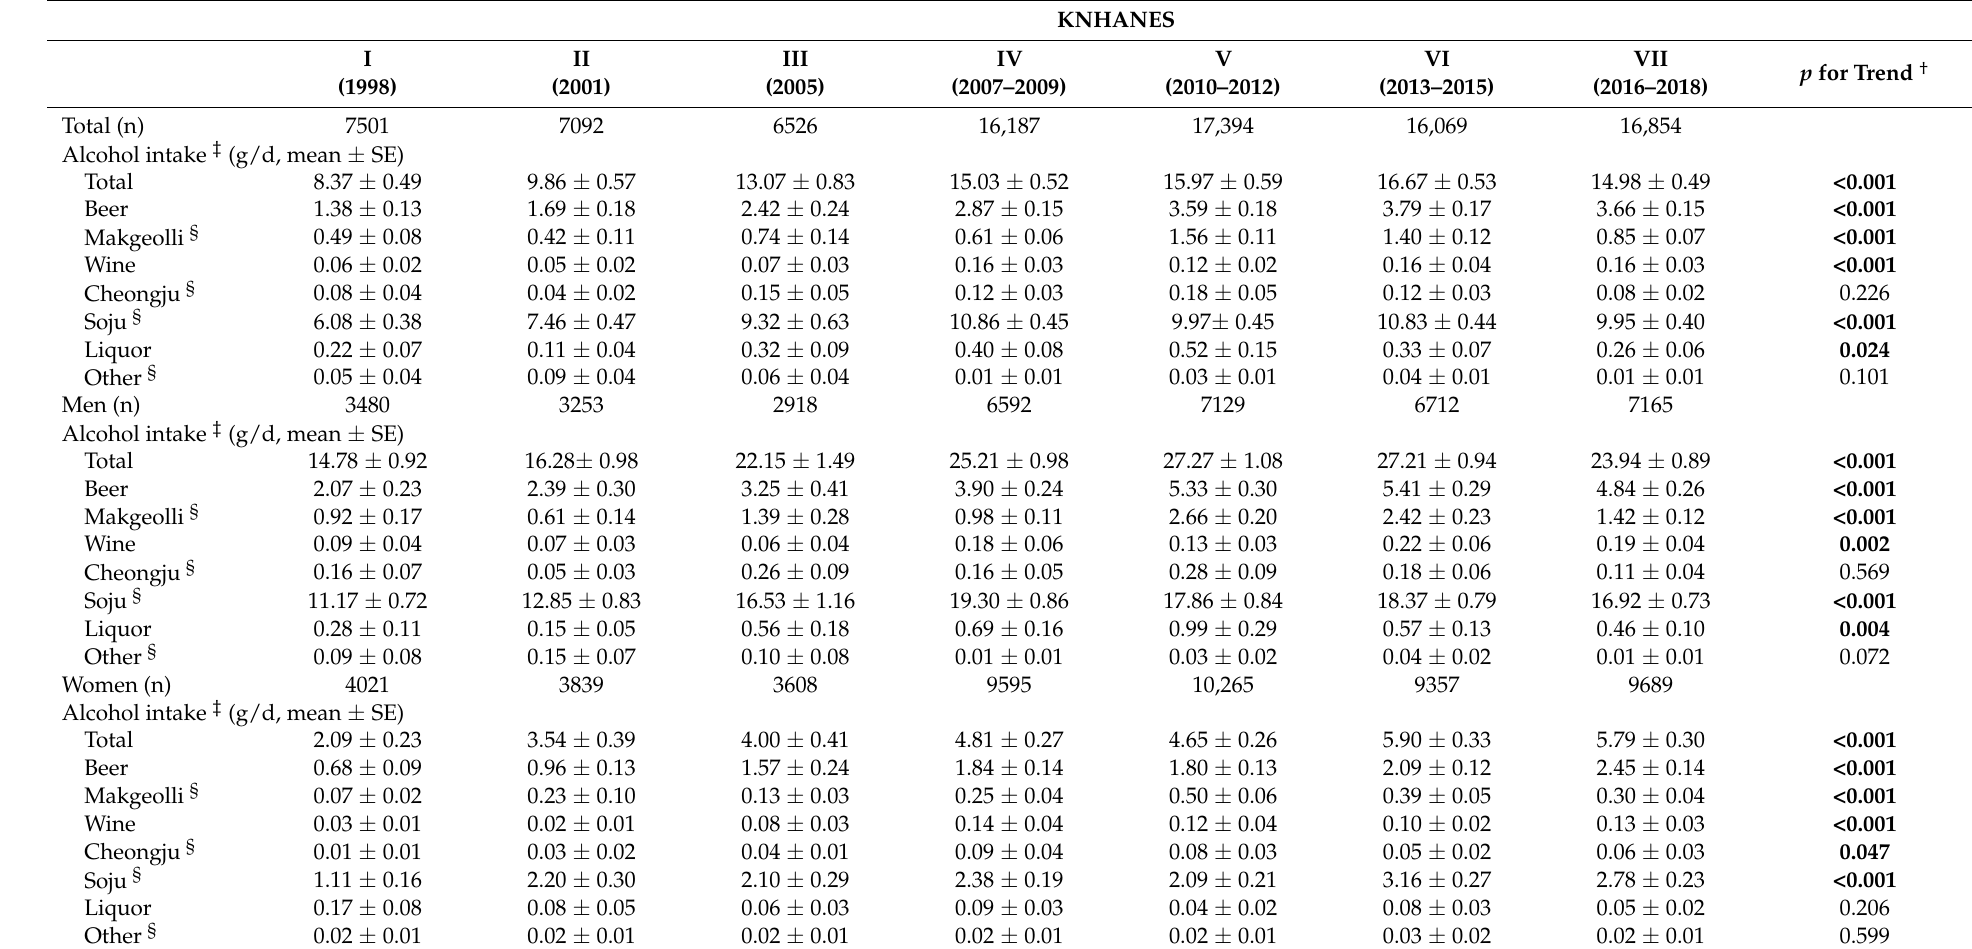
Bold values indicate p for trends < 0.05. † p for trends by multivariate linear regression. ‡ Age-standardized based on the 2005 Korean census, and p for trends adjusting for age. § Makgeolli as a traditional Korean rice wine, cheongju as a traditional Korean clear refined rice wine, soju as a Korean distilled spirit, and other including cocktail and